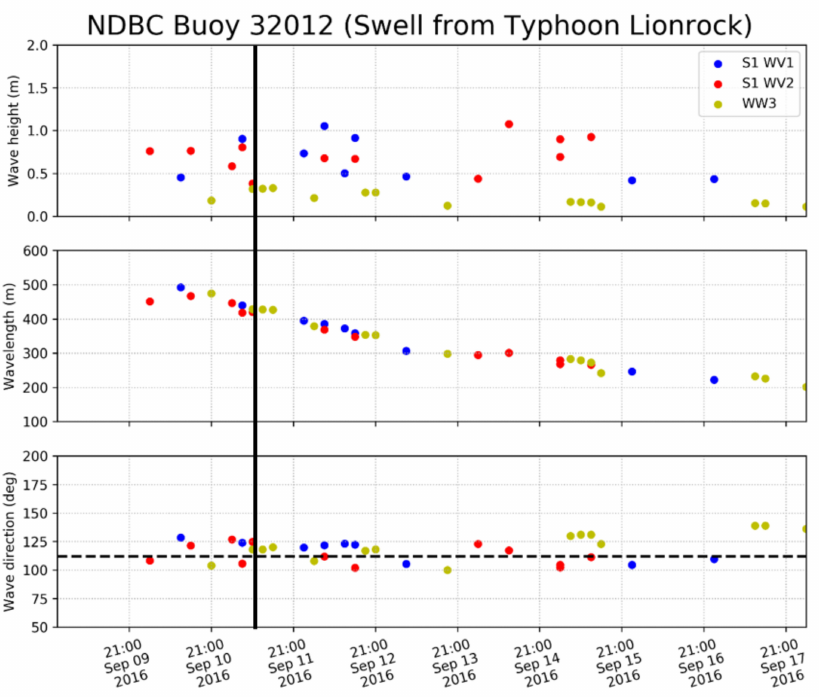
Figure 17. As in Figure 16, but for the case of a swell event originated from Typhoon Lionrock on 29 August 2016. The vertical black line corresponds to 12:00:00 UTC 11 September 2016 (the time of buoy observation presented in Figure